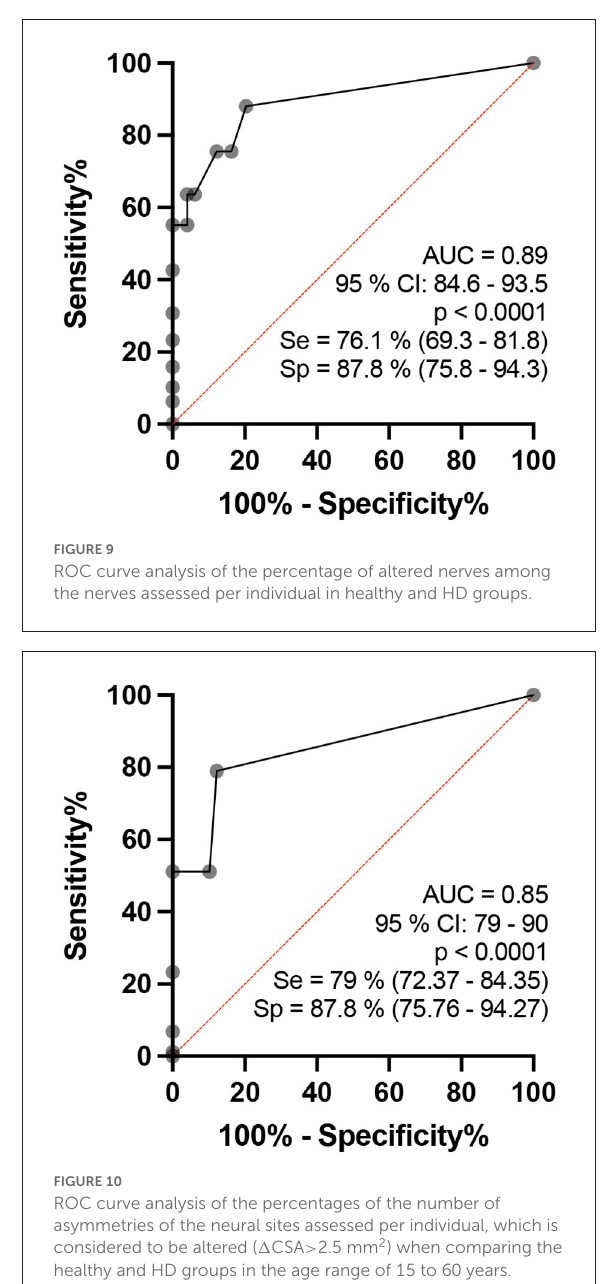
thickening, sensitivity is 72.4% and specificity is 87.8%, with an RR of 13. Regarding the 1 TPT of the ulnar nerve lesion, 40%